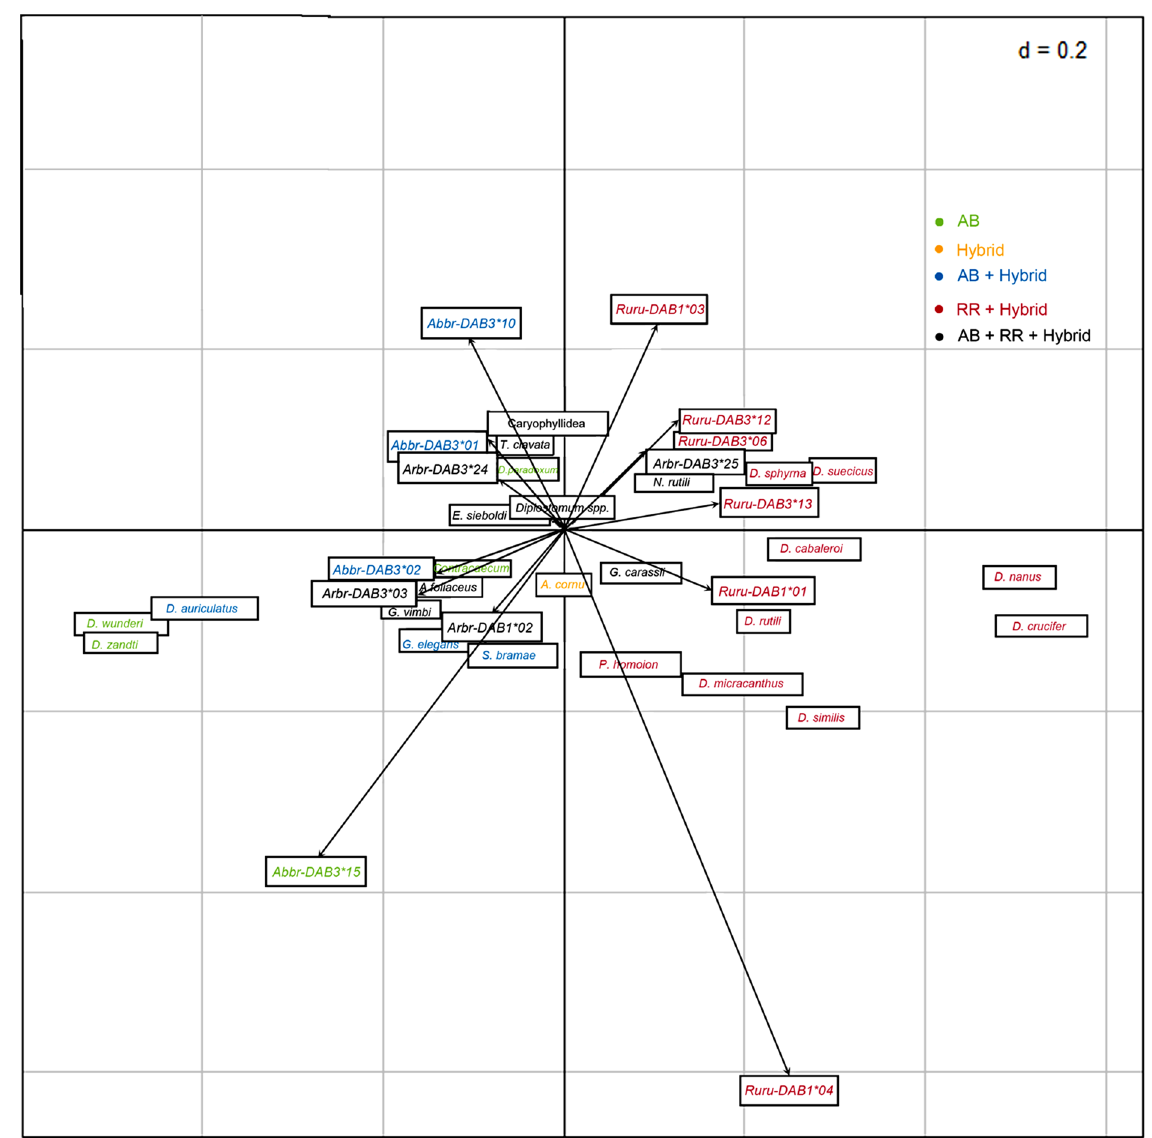
Figure 4. Co-inertia analysis (COIA) of the MHC genetic variation (MHC alleles data) and metazoan parasite species of common bream, roach and hybrids. Color labelling of DAB alleles and parasites corresponds to their presence in different fish groups or shared